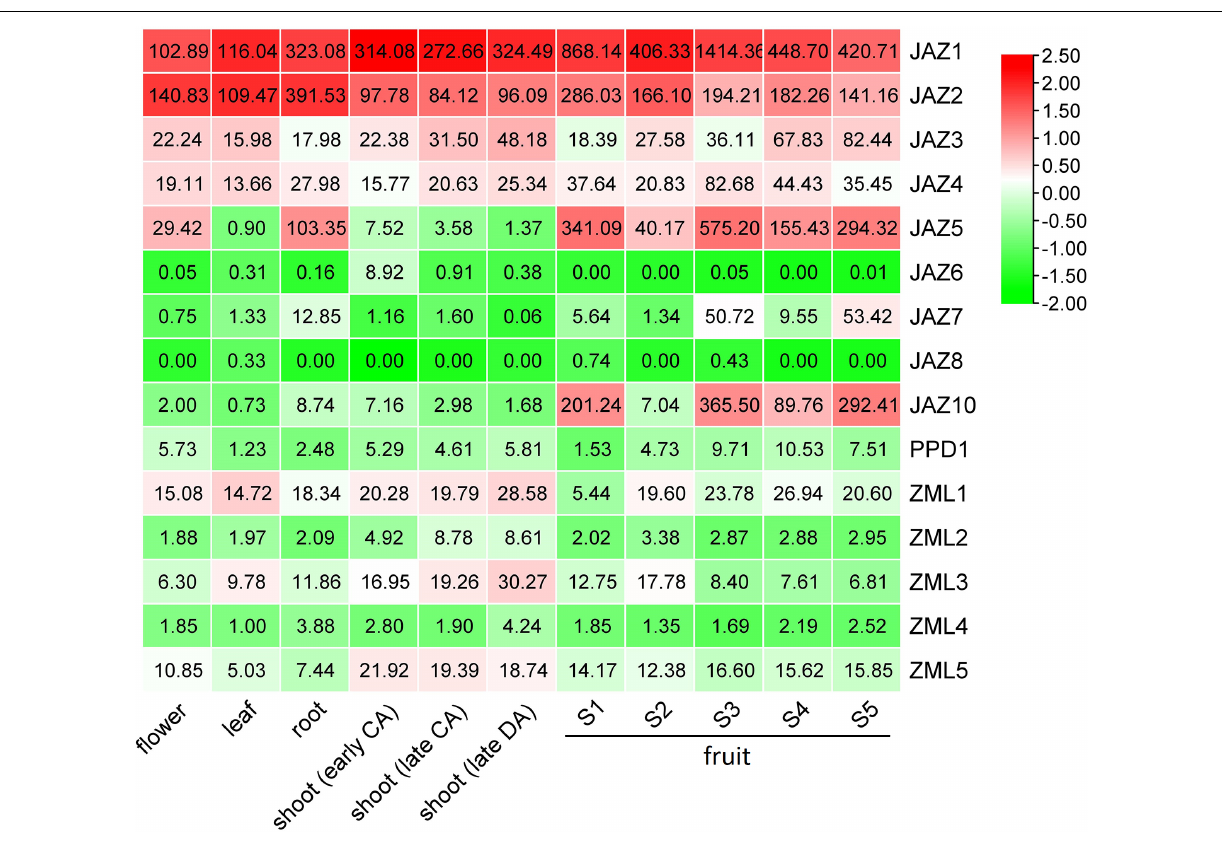
FIGURE 4 | Heatmap analysis of tissue-specific expression patterns of peach JAZ , PPD and ZML genes. The original TPM values of genes were normalized with a log transform and mean center columns. The values given in the boxes represent the original TPM values of genes, whereas the indicator ranges in the upper right corner represent the range of the values after normalization. CA, cold acclimation; DA, deacclimation; shoots during early CA, late CA and early DA represent shoots at the end of October, middle of January and middle of March, respectively; S1, the first exponential growth stage; S2, the pit hardening stage; S3, the second exponential growth; S4, fruit ripening stage; S5, fruit post ripening